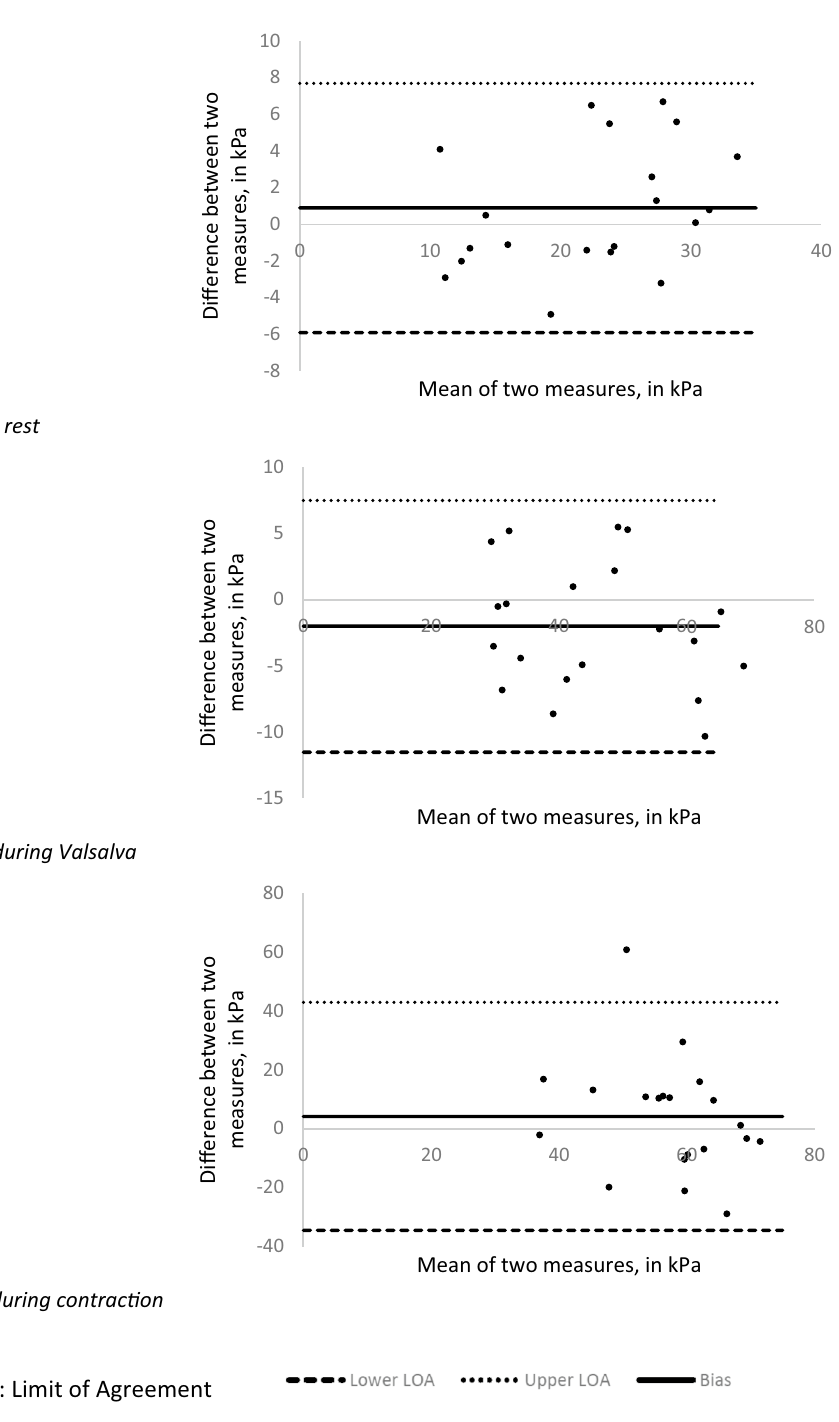
Figure 2. Bland–Altman plots of agreement between V1 (first visit) and V2 (second visit) for the mean levator ani muscle’s shear modulus assessment at each visit and each